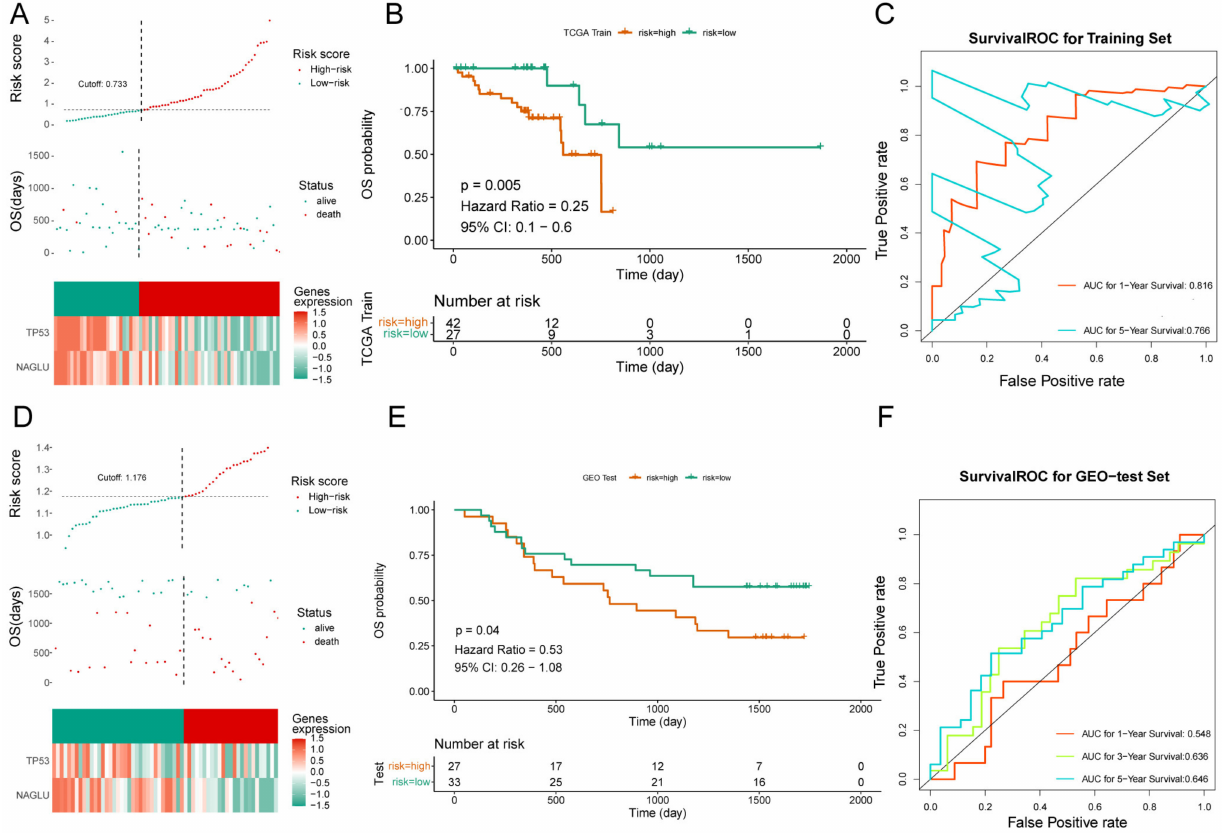
Figure 3. Risk model validation and evaluation. ( A ) Risk curve for high-risk subgroups in the training set. ( B ) Survival curve for high- and low-risk subgroups in the training set. ( C ) ROC curve of the training set. ( D ) Risk curve for high-risk subgroups in the validation set. ( E ) Survival curve for high- and low-risk subgroups in the validation set. ( F ) ROC curve of the validation